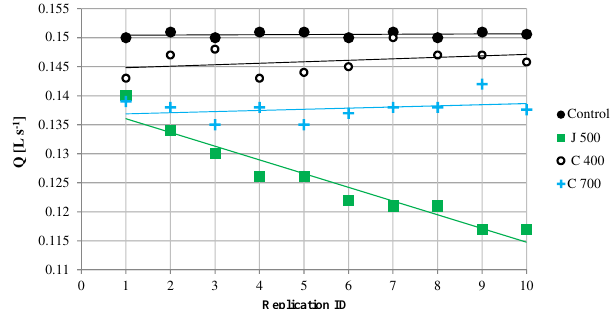
Figure 4. Peak discharge at outlet section, Q (Ls − 1 ) ; linear trend- lines included; laboratory